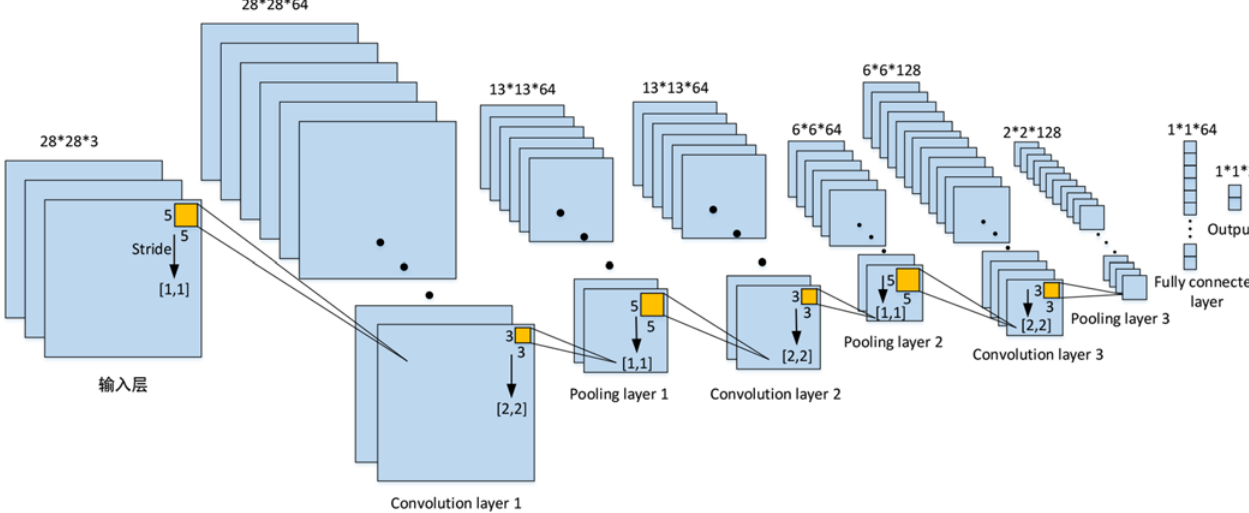
Fig. 10. The detailed structure of the CNN network.